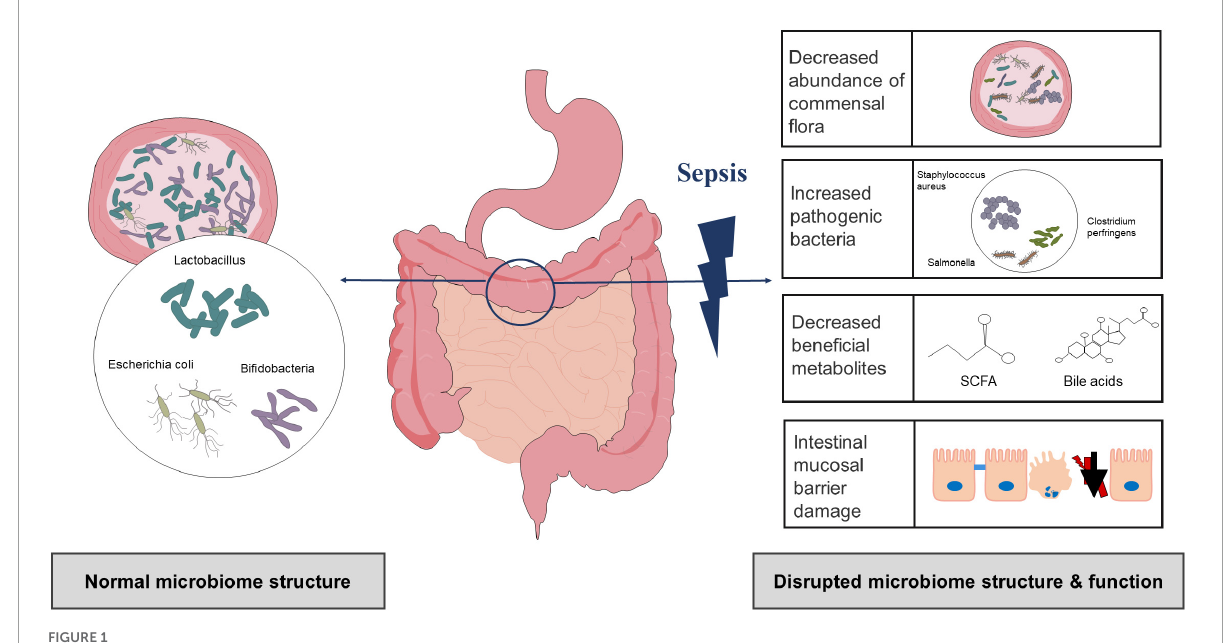
FIGURE1 Gut microbiota alterations in sepsis.